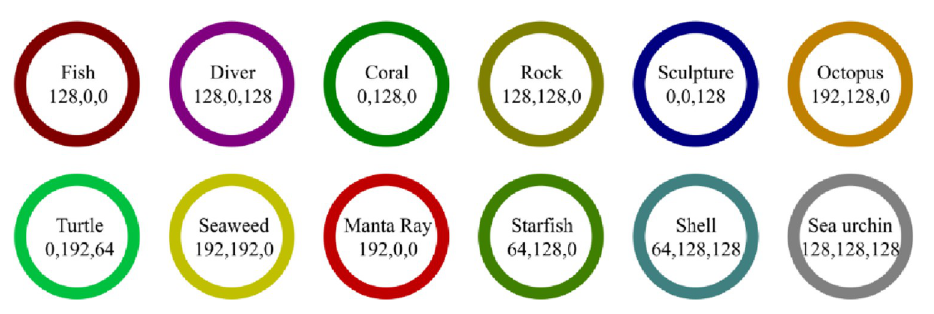
Fig 9. The color representation of labeled